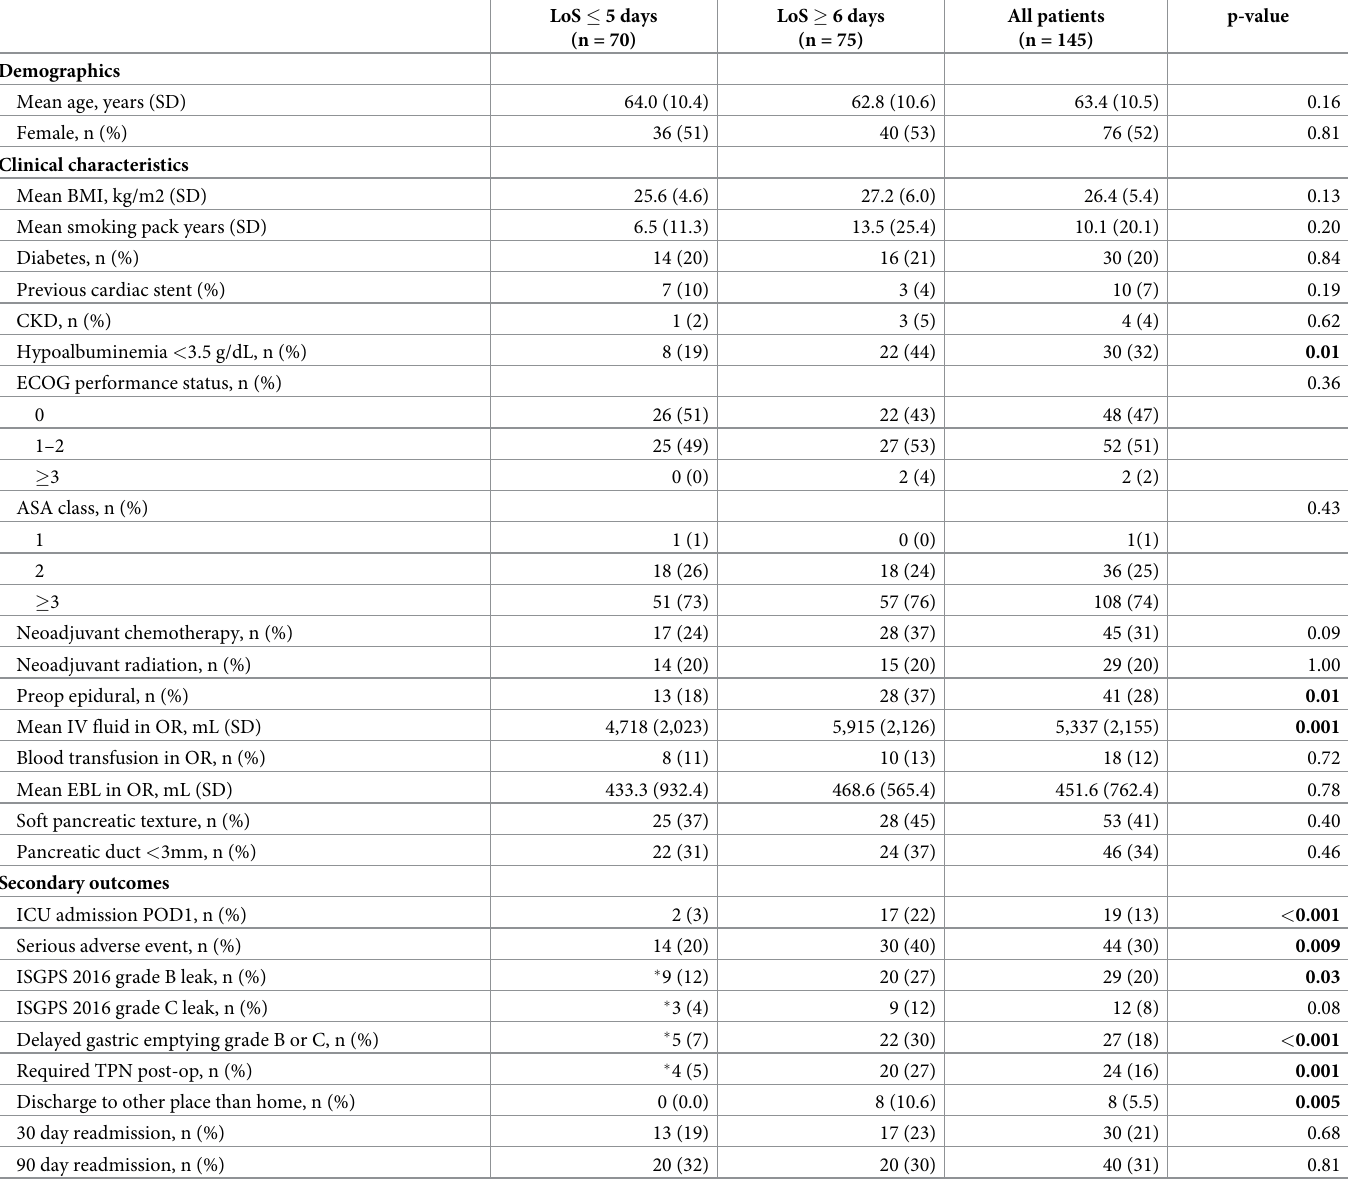
Table 2. Demographics, clinical characteristics, and outcomes of patients with LOS within goal of 5 days after PD or not.